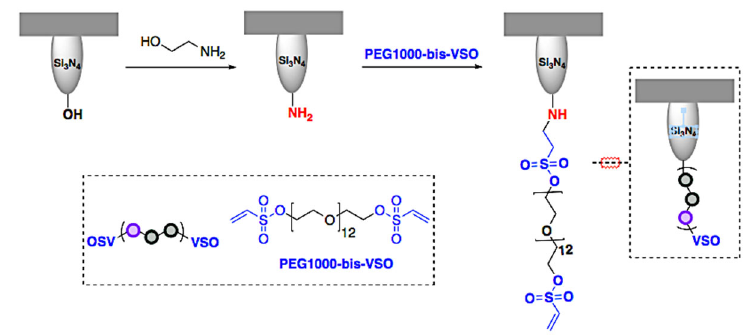
Figure 1. Preparation of the tip bounded to PEG1000-VSO.